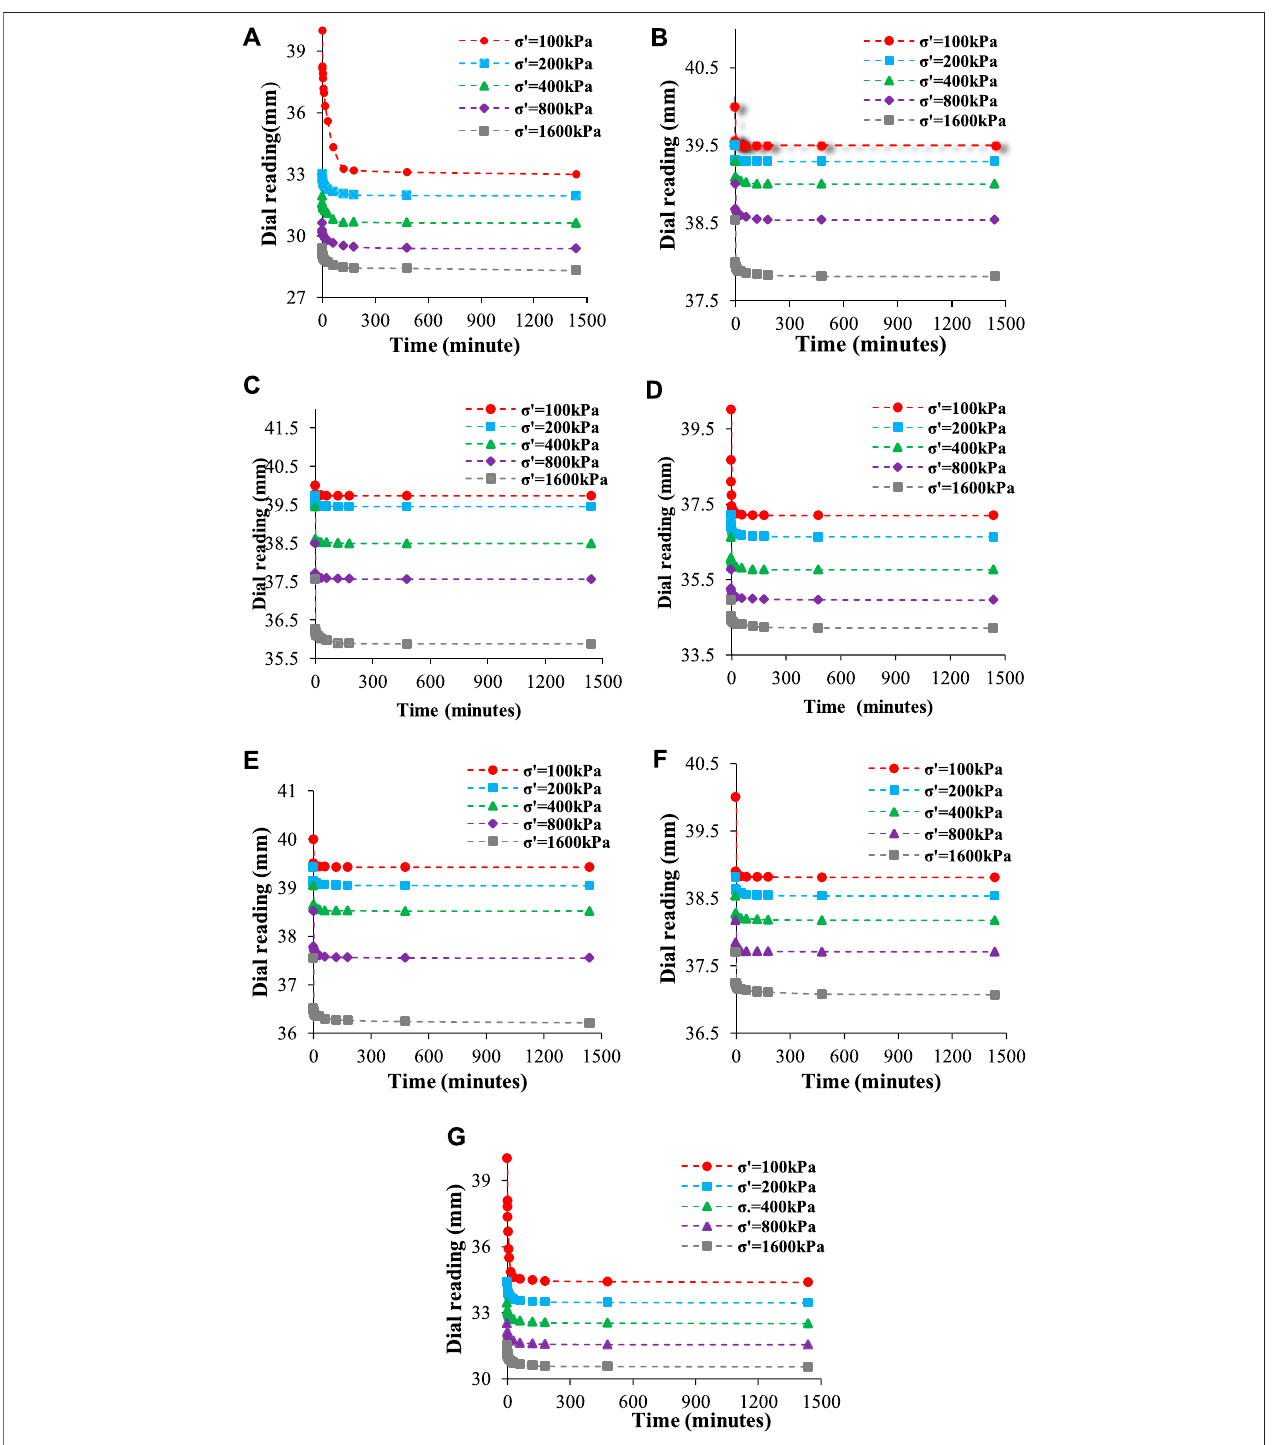
FIGURE5| Dialreading-timeduringconsolidationforloadincrement. (A) Finespecimen; (B) mediumspecimen; (C) coarsespecimen; (D) 1:1:1specimen; (E) 1:2: 4 specimen; (F) 1:4:2 specimen; (G) 4:1:2 specimen.